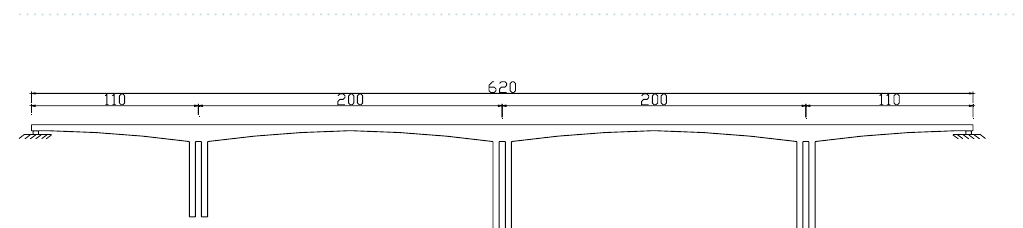
Figure 2. Composition of prestress loss.